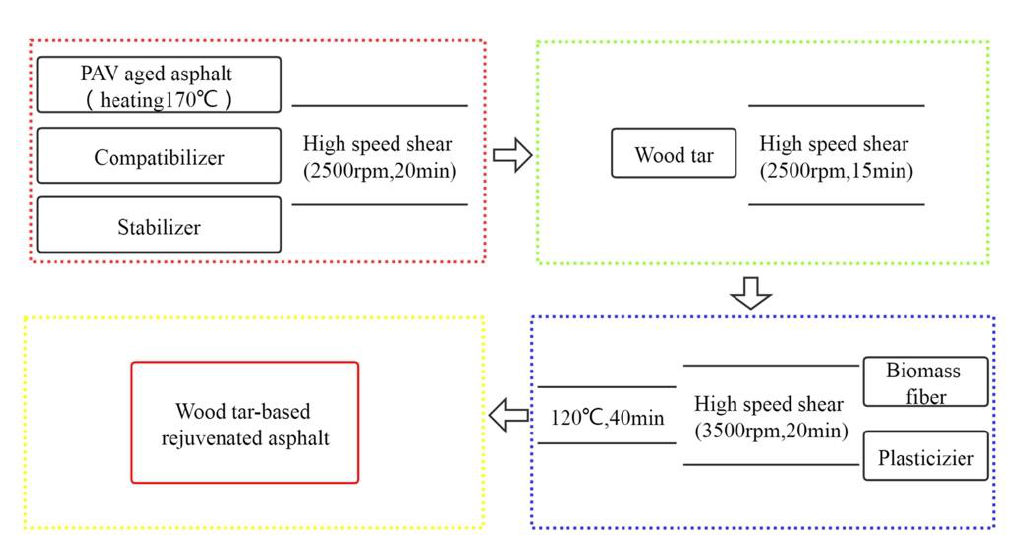
Figure 3. Test scheme. 2.3.1. Penetration The test is conducted according to penetration of asphalt test method T0604-2011 in JTG E20-2011 [39]. Firstly, the asphalt sample is injected into a standard sample dish, cooled for 1.5 h at room temperature, and then placed in a thermostatic water bath at 25 °C ± 0.1 °C for 1.5 h. The 5-s penetration value of 100 g ± 0.05 g standard needle is the penetration value of asphalt. The higher the penetration value, the softer the asphalt [40]. 2.3.2. Softening Point